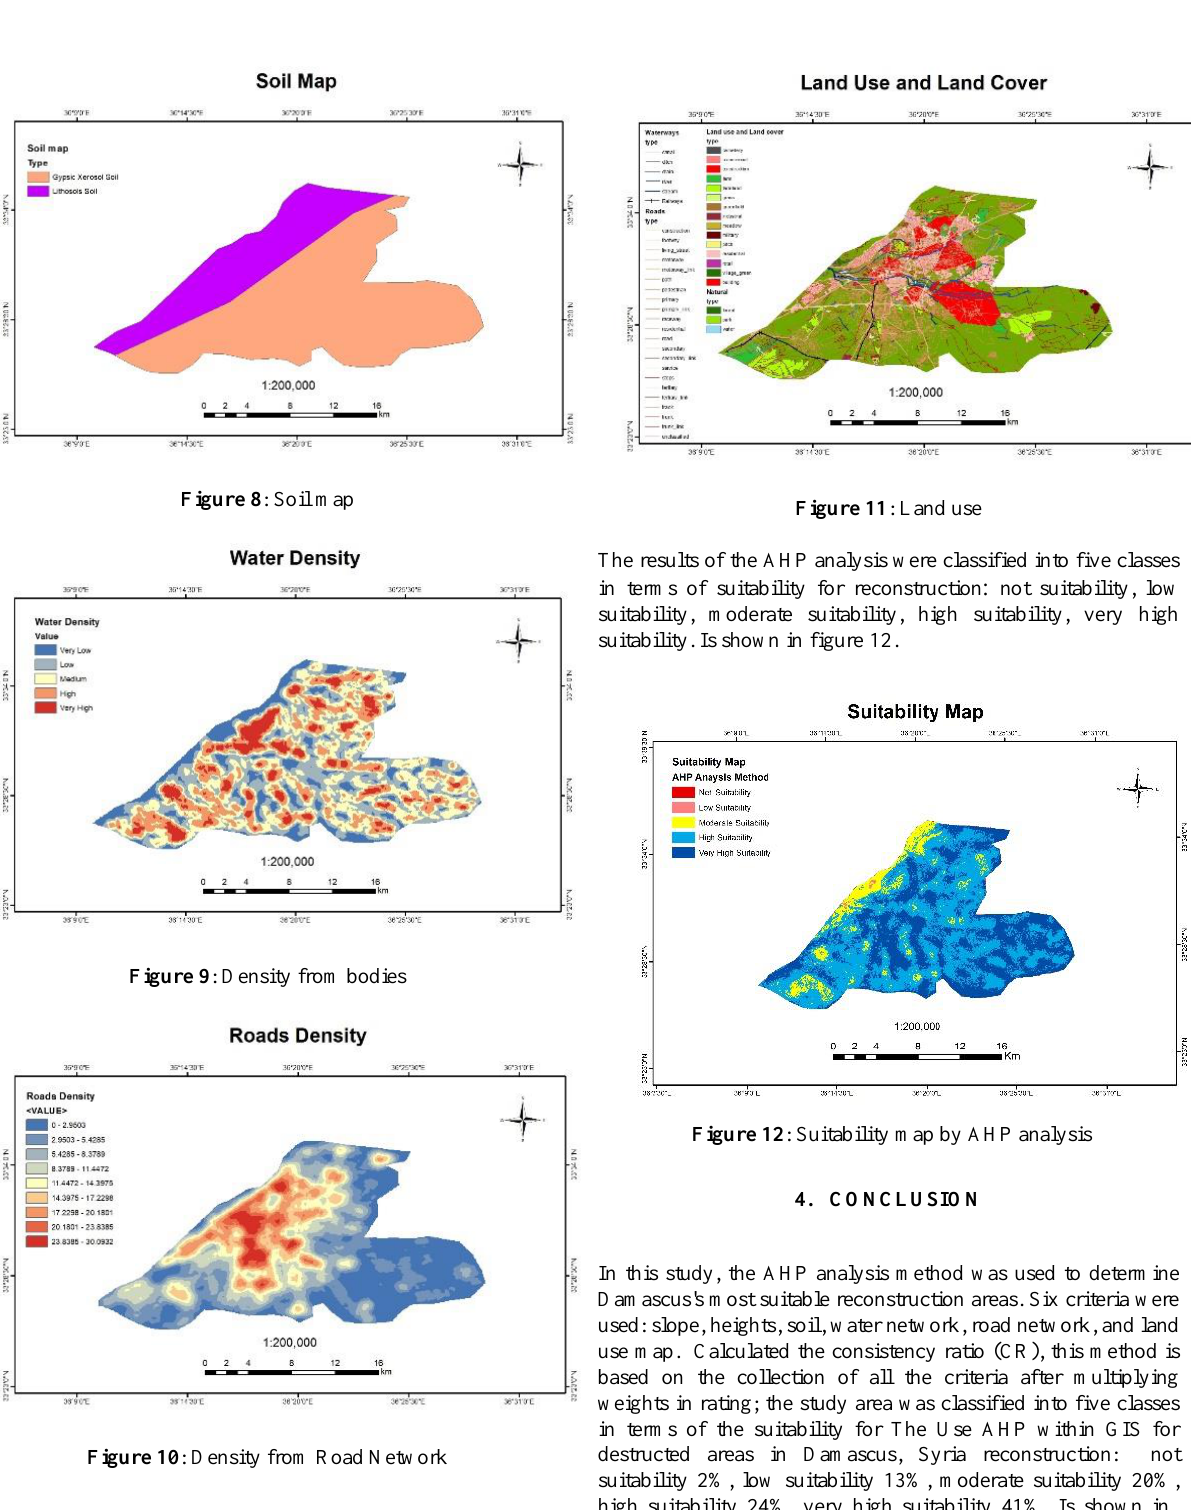
Figure 10 : Density from Road Network